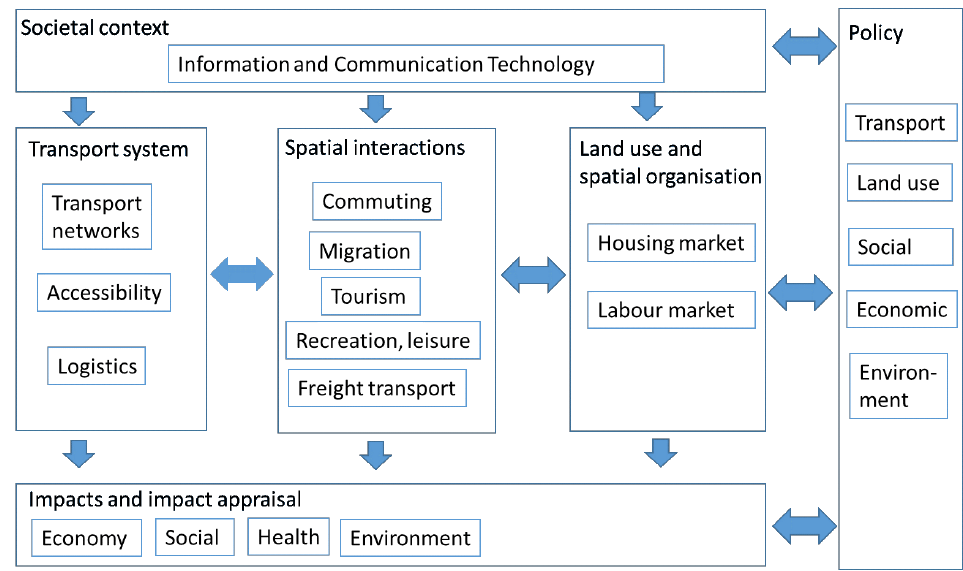
Figure 1: The scope of the